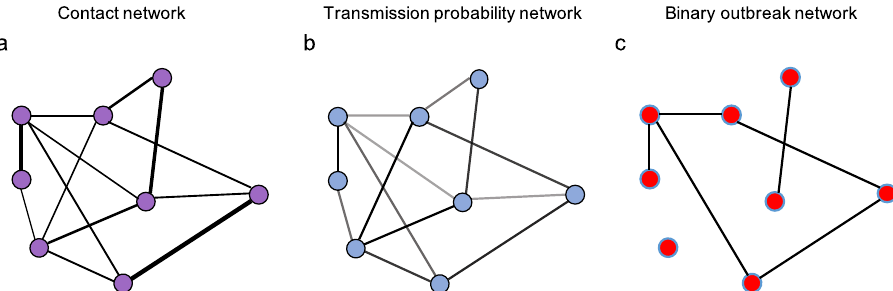
Fig. 7 How contact, transmission and binary outbreak networks relate to each other. a A schematic of a contact network, the width of the edges shows the number of unique contact pairs between schools. b A schematic of a transmission probability network calculated from the contact network; the shading of the edges shows the relative probability of transmission between schools. c A schematic of a realisation of a binary outbreak network, where edges are weighted 1 with probability given by the equivalent edge in the transmission network — indicating transmission between schools, or 0 otherwise. Blue highlighted nodes show those in the largest connected